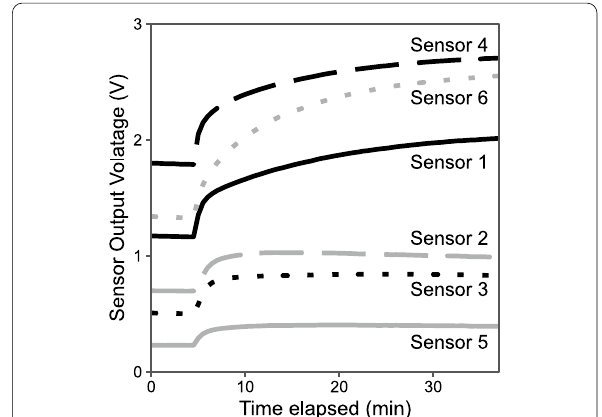
Fig. 4 Voltage change of the sensors responding to the decayed sample